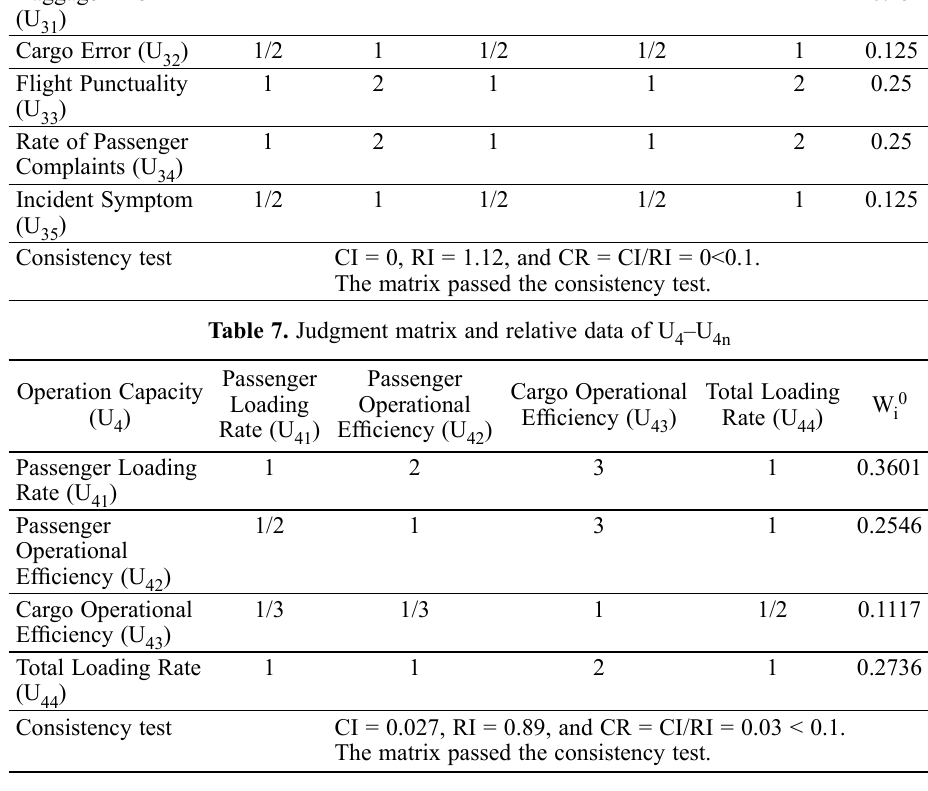
Table 8. Judgment matrix and relative data of U